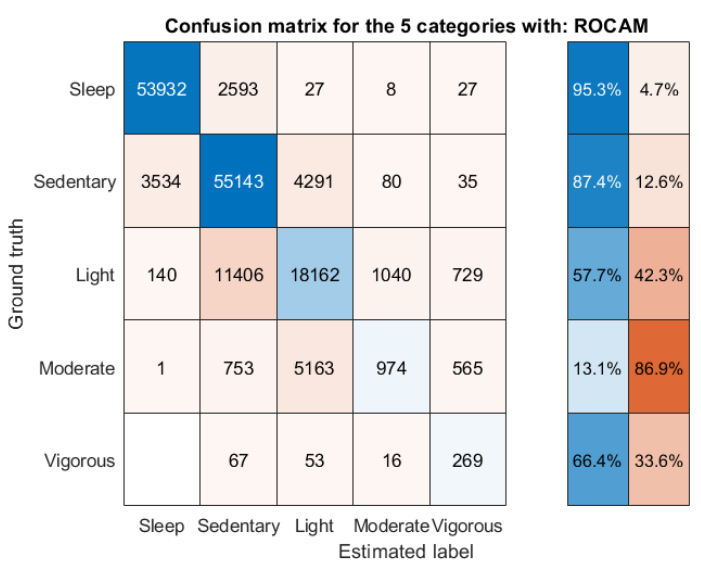
Figure 4. Minute-wise confusion matrix to estimate the five categories (sleep; sedentary, light, moderate, and vigorous PA) by using optimized thresholds for ROCAM with accelerometry data sampled at 10 Hz. On the right-hand side, we have the percentage of correctly vs. incorrectly matched labels for each of the five categories. Overall accuracy: 80.8%. The results refer to out-of-sample performance and were computed by using the leave-one-participant-out approach, wherein we collated all outputs in a single confusion matrix.